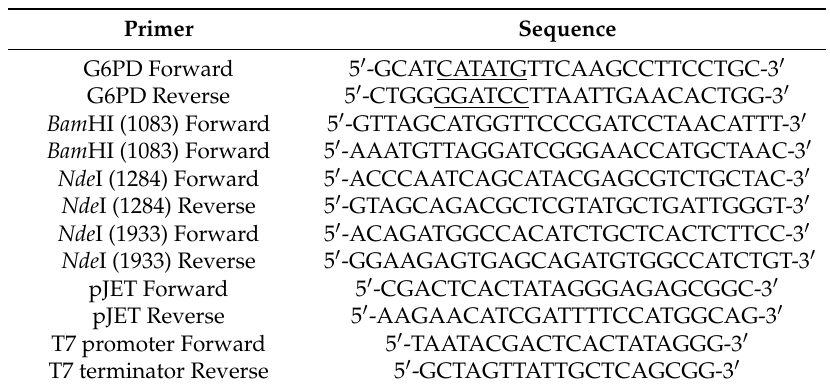
Table 3. Primers used in this